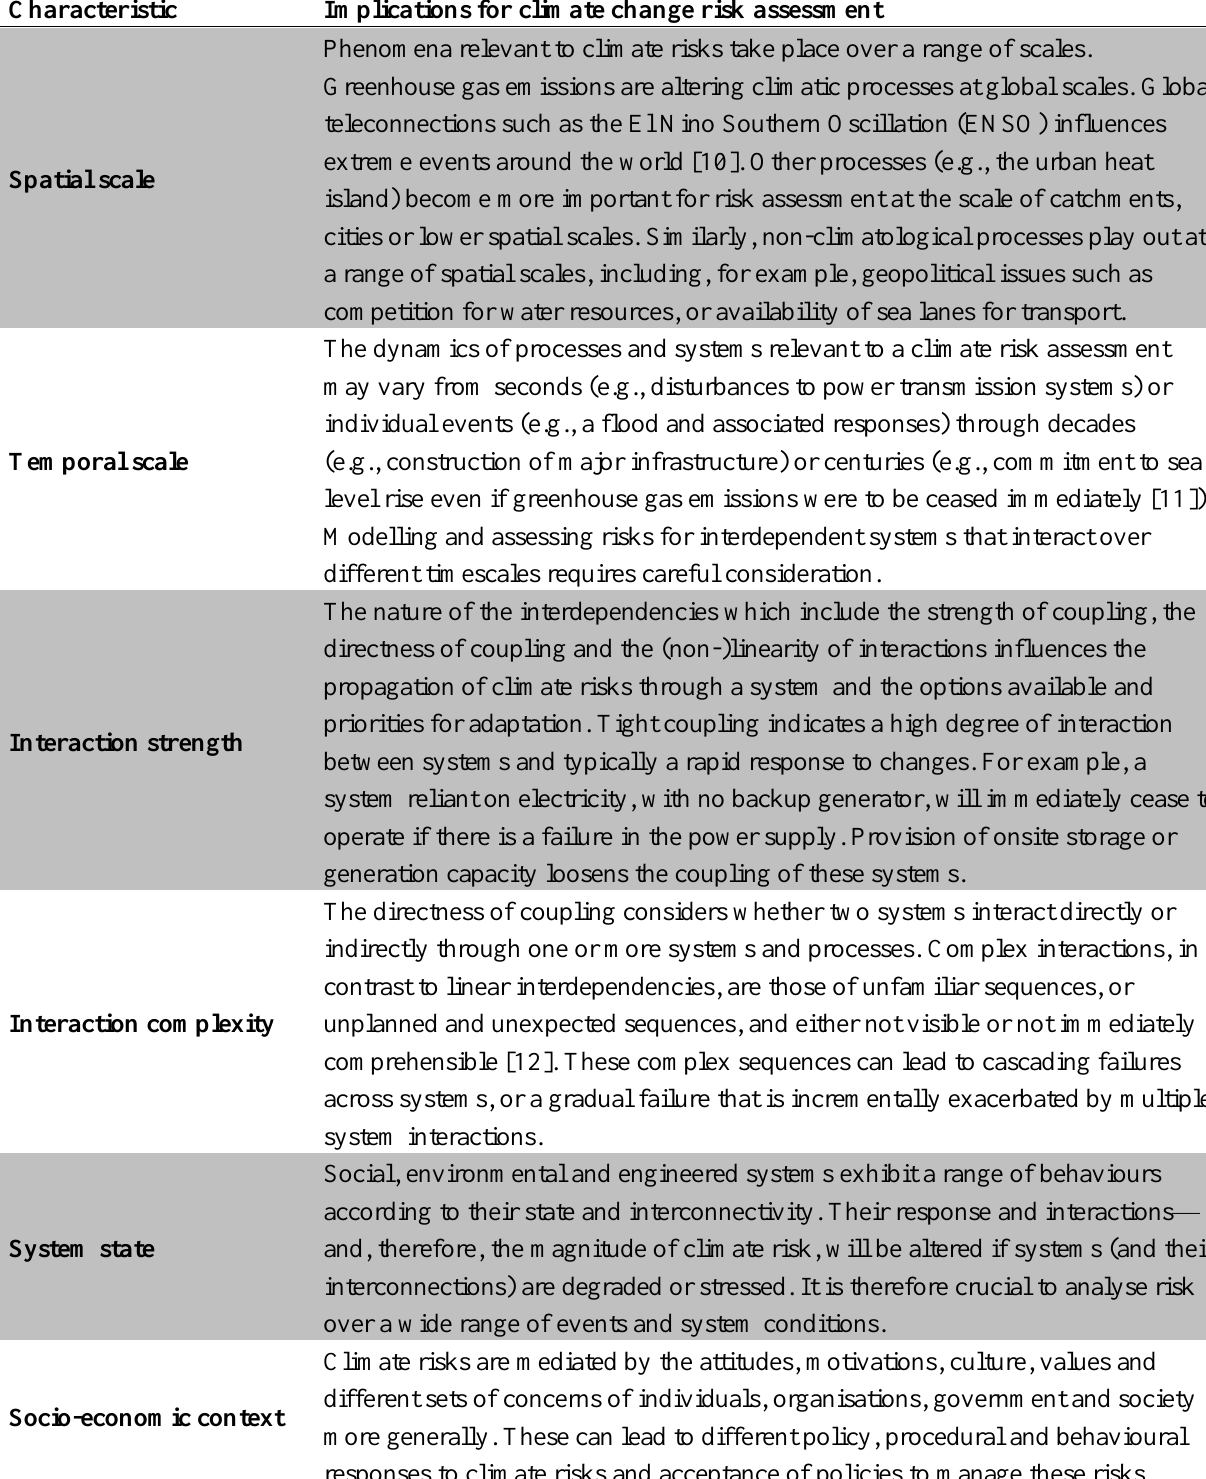
Table 1. Additional factors that need to be considered to fully characterise an interdependency in the context of a climate change risk